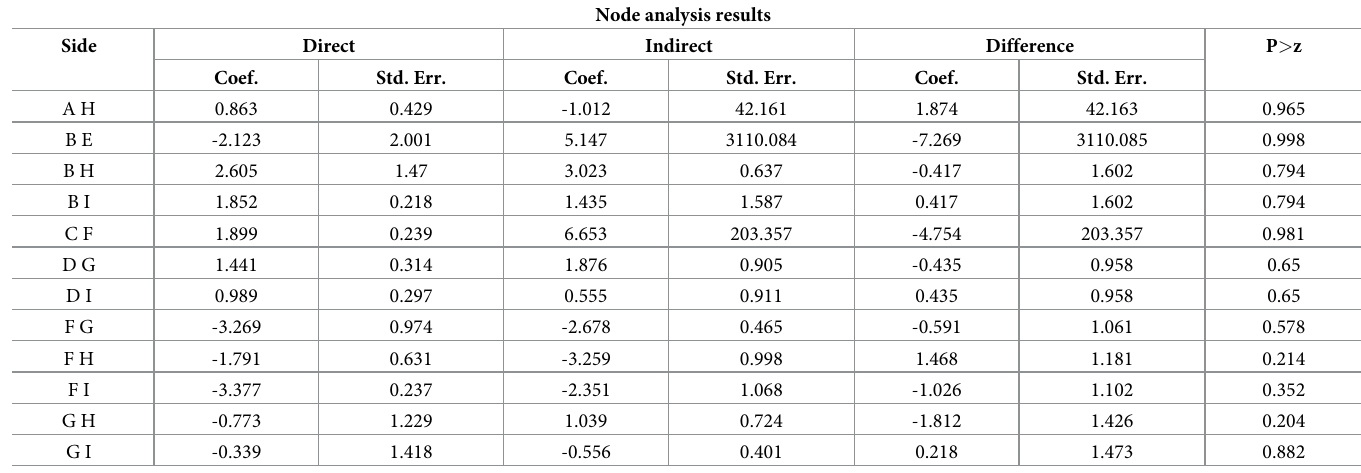
Table 3. Node analysis.